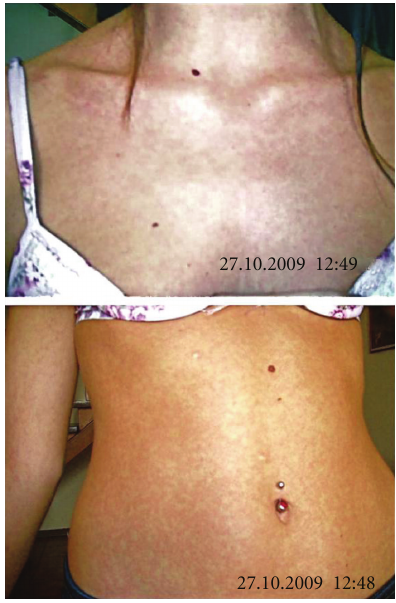
Figure 1: The rash present on the patient’s trunk 11 days after the infliximab